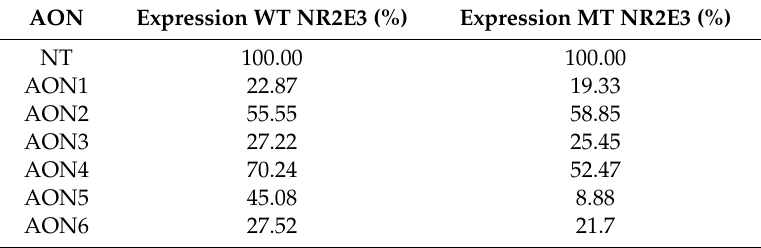
Figure 3. Western blot analysis. Wild type (WT) or mutant (MT) NR2E3 was overexpressed in RPE-1 cells and subsequently treated with AON1–6. ( A ). Upper images represent NR2E3 protein visualization, lower images represent β -tubulin visualization. ( B ). Densitometric analysis for three independent Western blots. Left panel represents WT samples, right panel represents MT samples. All AONs lead to a partial knock-down of WT and MT NR2E3 protein ( p -values between < 0.0001 and 0.0328). Error bars represent standard deviation between relative densities. Table 3. Relative protein expression values from wild type (WT) or mutant (MT) NR2E3 overexpressed in RPE-1 cells and subsequently treated with AON1–6. Average residual protein expression after treatment with AON1–6 was calculated from three independent blots relative to the non-treated (NT) sample (=100%).